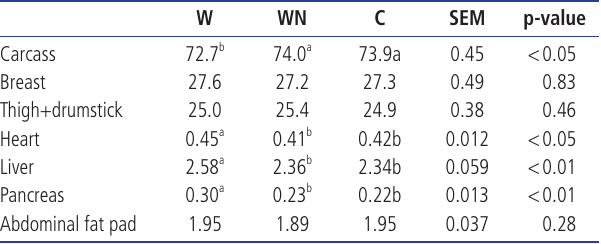
W, wheat-based diet; WN, wheat-based diet+Natuzyme Plus; C, corn-based diet;